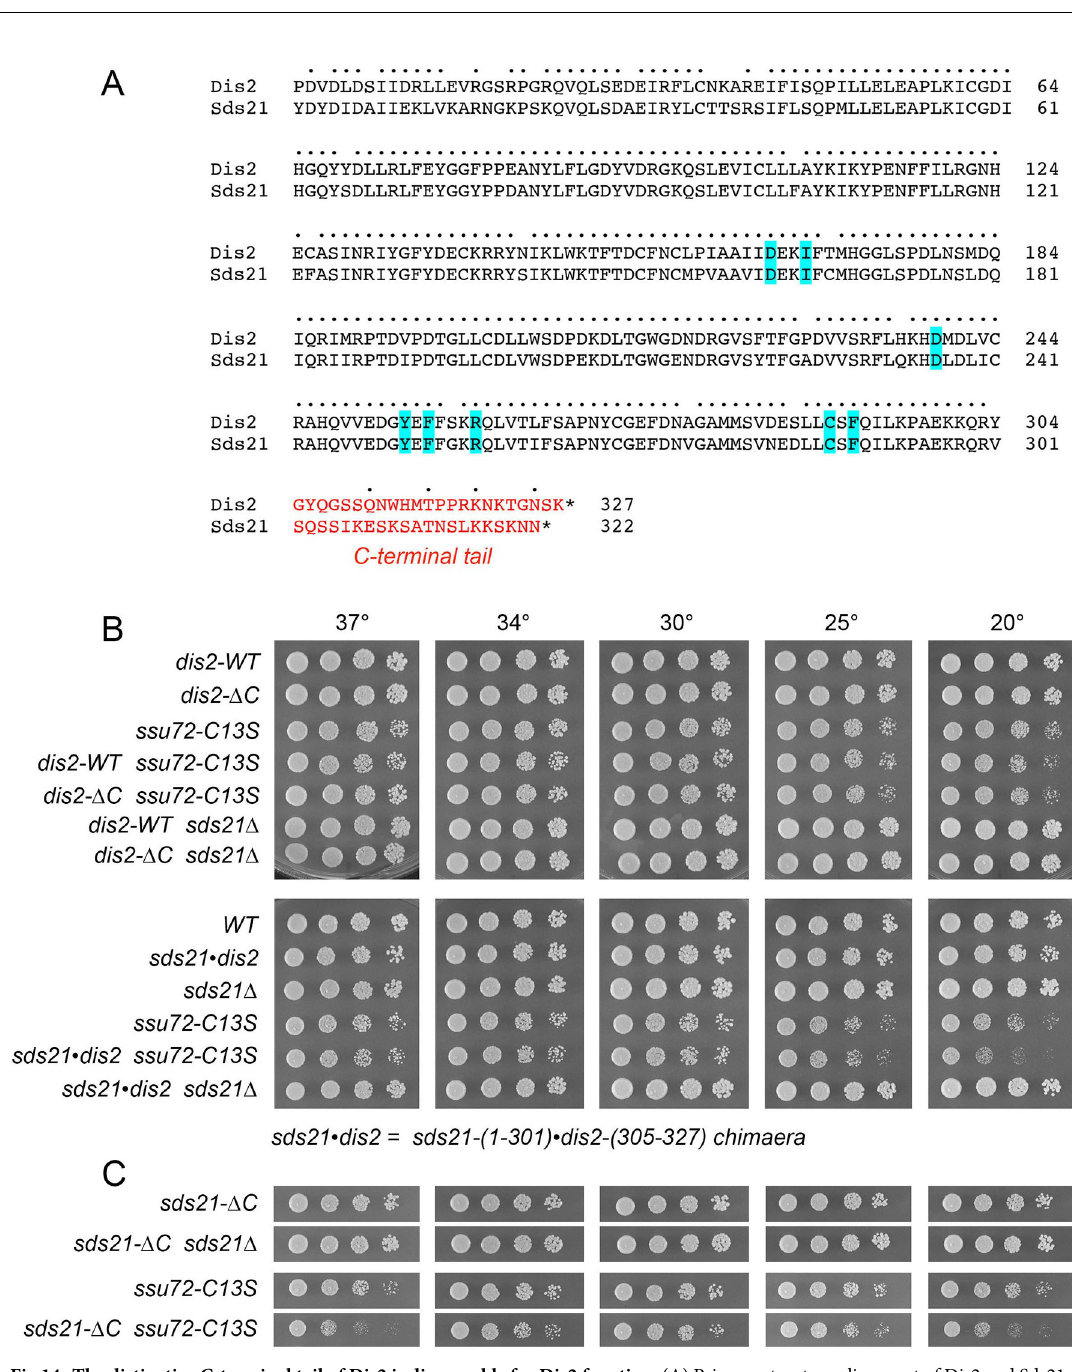
Fig 14. The distinctive C-terminal tail of Dis2 is dispensable for Dis2 function. (A) Primary structure alignment of Dis2 and Sds21, with positions of amino acid side chain identity/similarity indicated by dots. The divergent C-terminal tails are shown in red font. The amino acids predicted to comprise the Ppn1 binding pocket are highlighted in blue. (B and C) S . pombe strains as specified on the left were spot-tested for growth on YES agar at the indicated